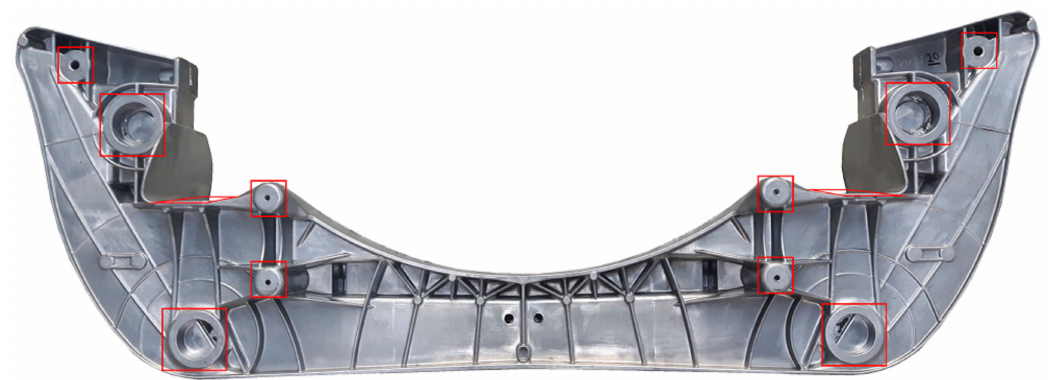
Figure 1. Cross beam design and the main areas connected with the other suspension elements (highlighted in red colour).